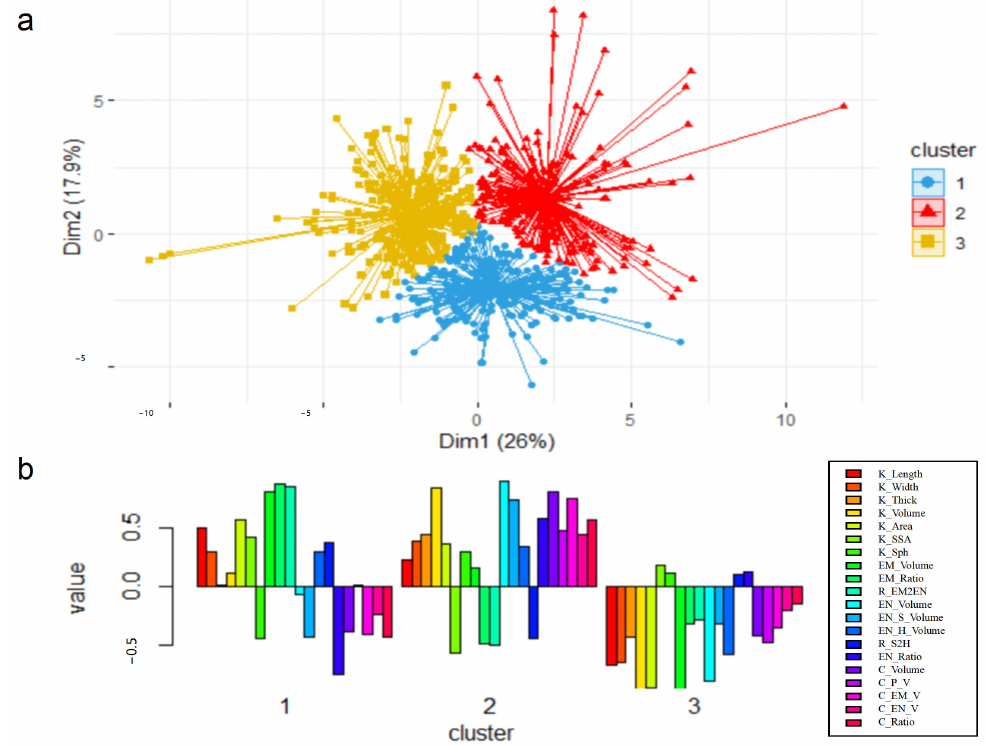
Figure 3. Results of cluster analysis of kernel traits for the maize association analysis population. Note: ( a ) the results of the cluster analysis of kernel traits. ( b ) the weights of phenotypic parameters for cluster